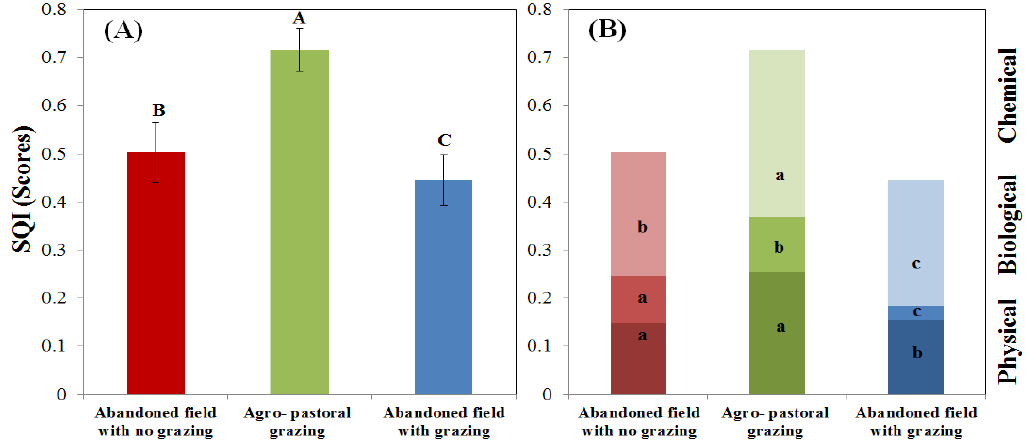
Figure 4. ( A ) Scores of soil quality indices (SQIs) for the three land uses in the Migda site, Israel: abandoned field with no grazing (red color), agro-pastoral grazing (green color), and abandoned field with grazing (blue color); and ( B ) the SQI that was calculated by physical, biological, and chemical analyses. Capital letters above the error bars represent significant differences between land uses. Small letters within the columns represent significant differences between soil